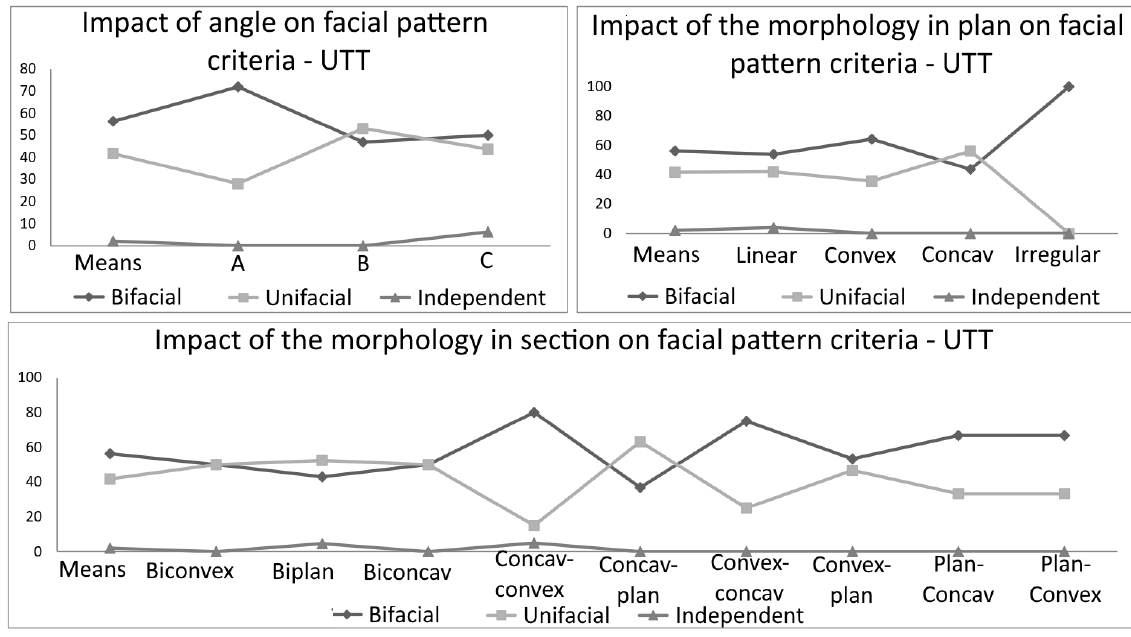
Figure 7. Impact of the cutting edge morphology on the repartition